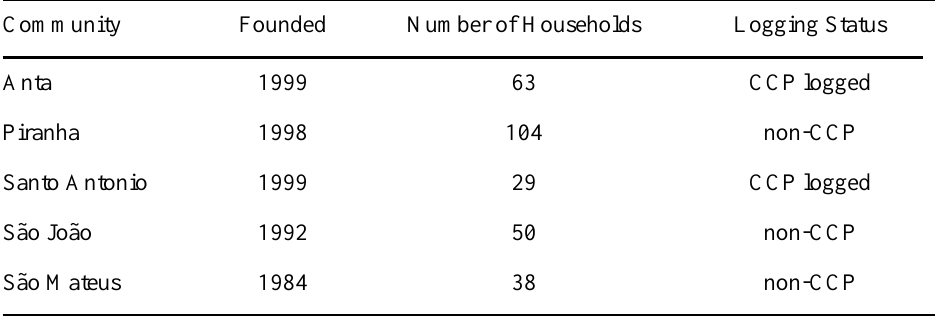
Table 1. Community age, size, and company–community partnership (CCP)